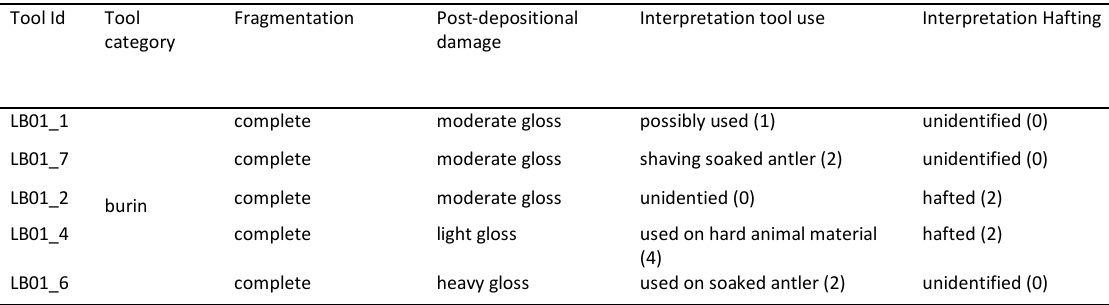
Table 5 . Overview of the five burins from locus LB01 with use-wear evidence (level of certainty related to the interpretation: uncertain (0) poor certainty (1); moderate certainty (2); high certainty